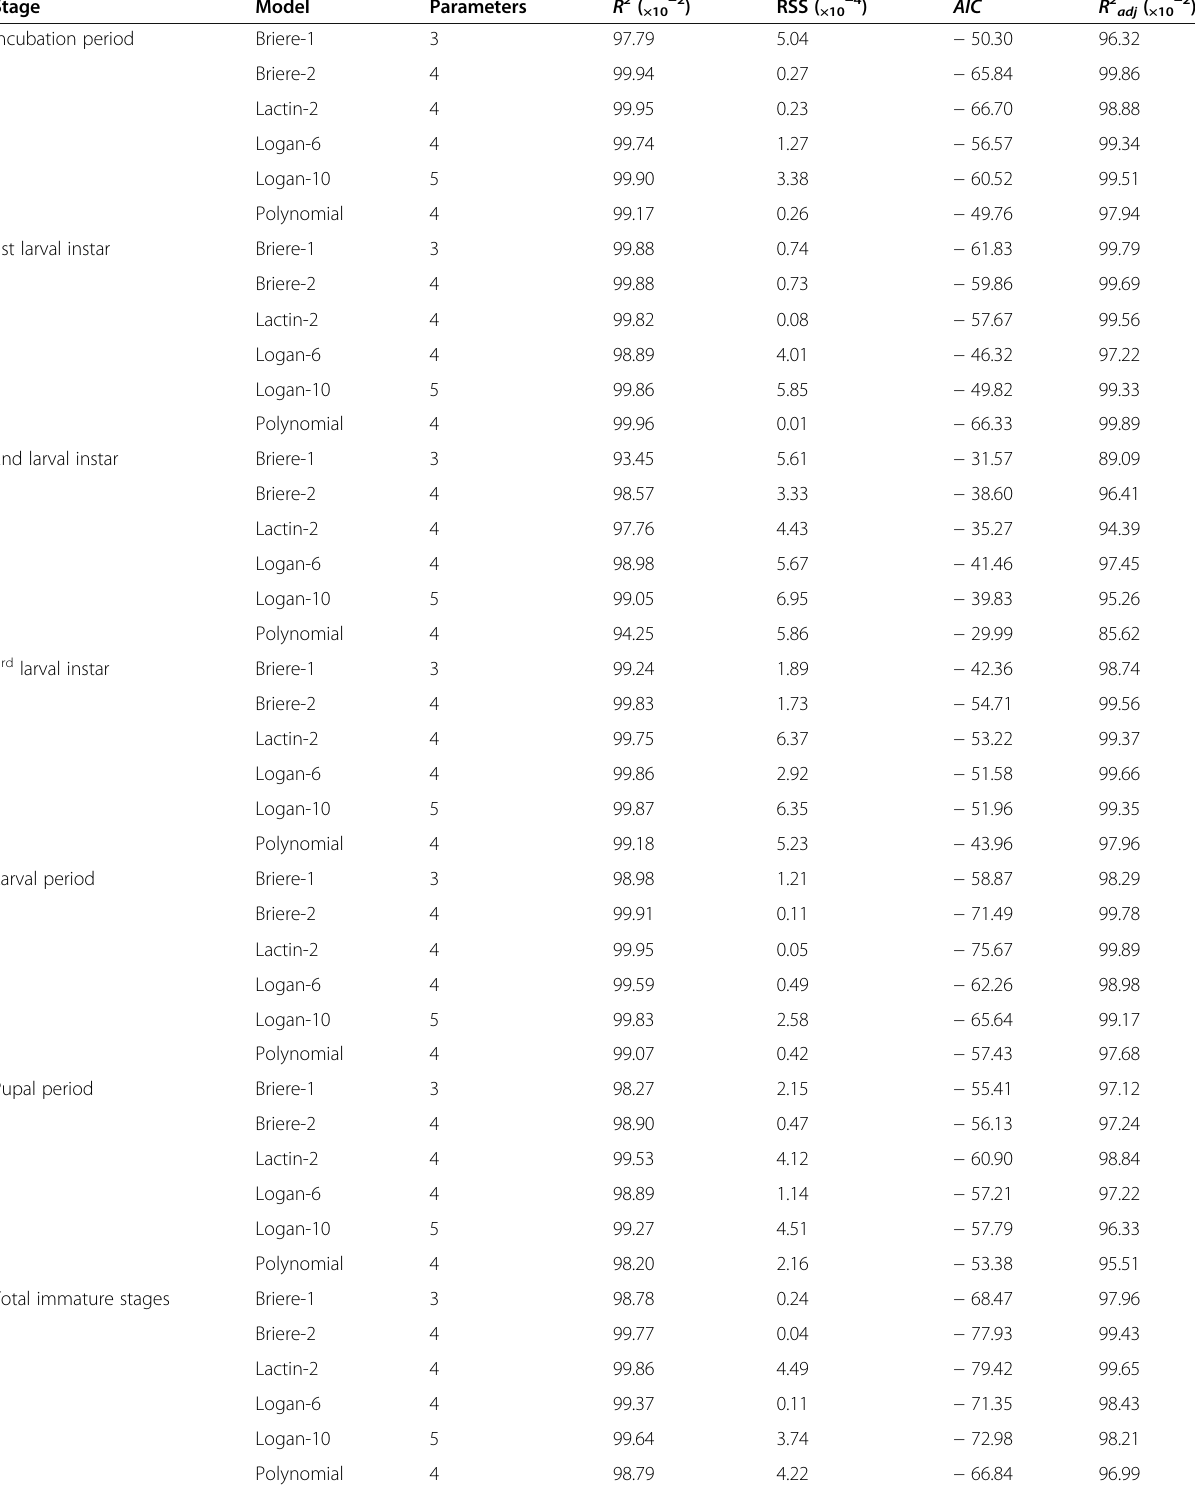
Table 3 Comparison of six non-linear models of developmental rate for describing the effect of temperature on developmental rate of the common green lacewing, Crysoperla carnea Stage Model Parameters Incubation